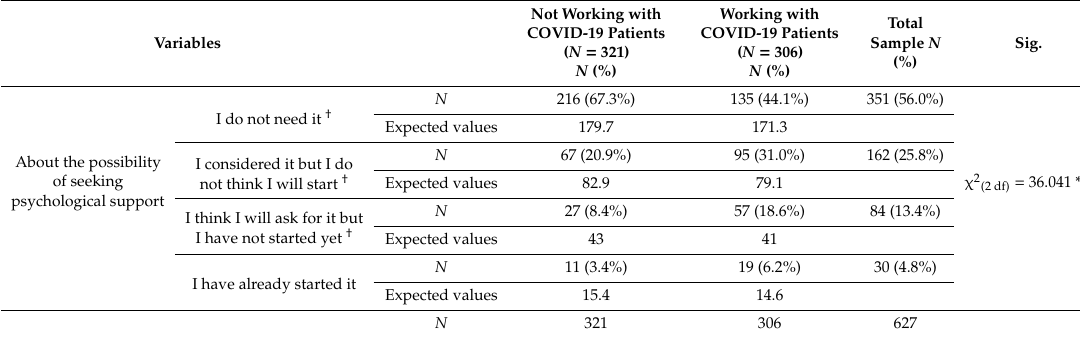
Table 4. Distributions of the variables levels between healthcare professionals working or not working with COVID-19